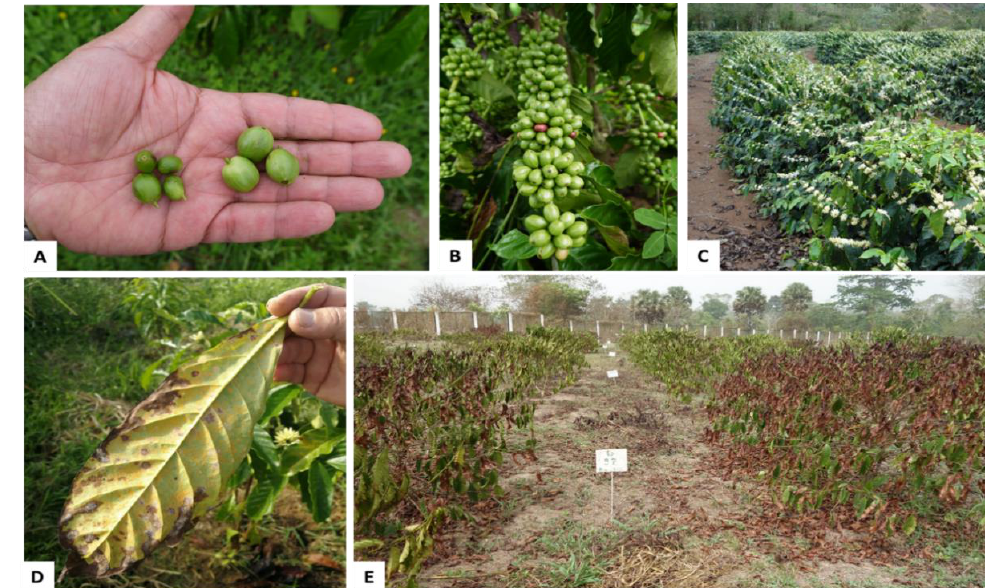
Figure 1. Illustration of important characteristics for varietal selection of Robusta coffee. ( A ), grain size; ( B ), productivity; ( C ), uniformity of flowering; ( D ), lack of rust or other diseases; ( E ), drought tolerance. Pictures: Juan Carlos Herrera- Nestle. 2021.